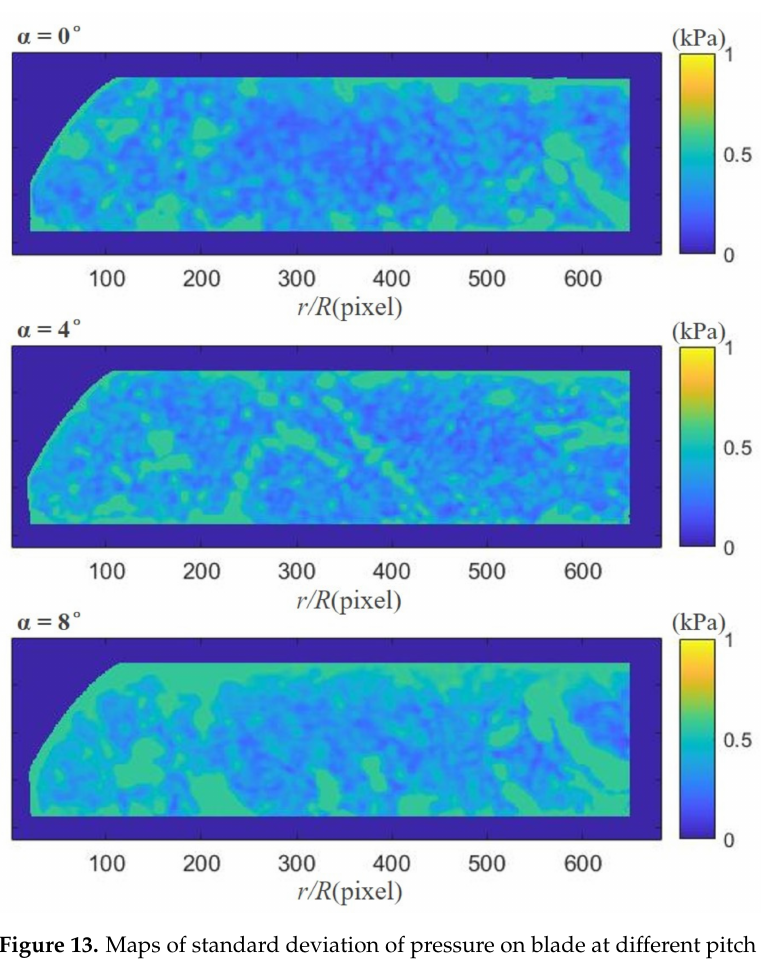
Figure 13. Maps of standard deviation of pressure on blade at different pitch angles.